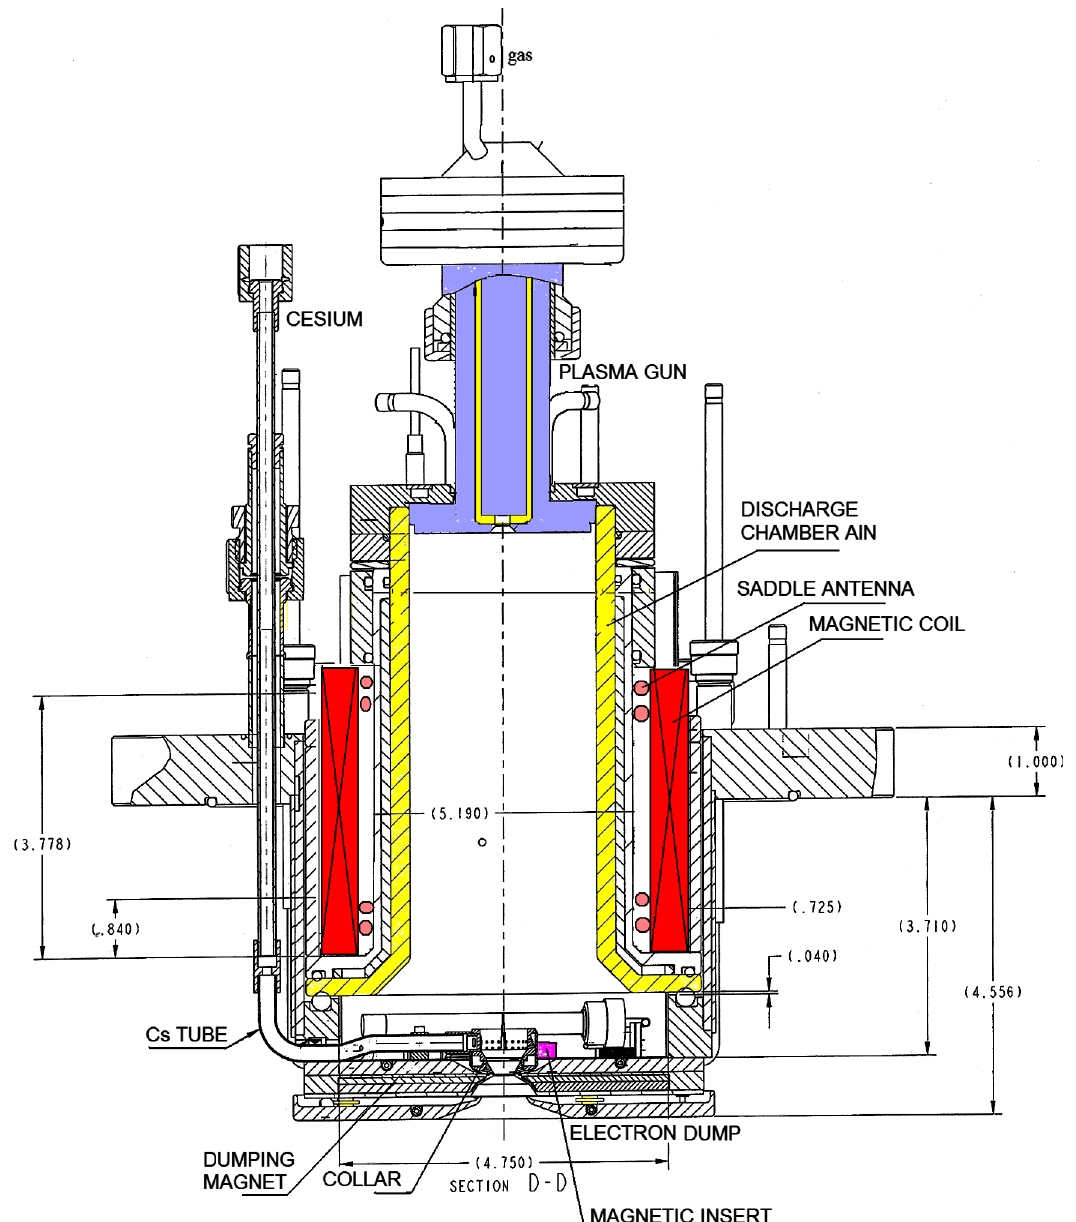
FIG. 7. Diagram of large volume SPS with saddle rf antenna, magnetic coil, and glow discharge plasma gun igniter (7 mm diameter emission aperture